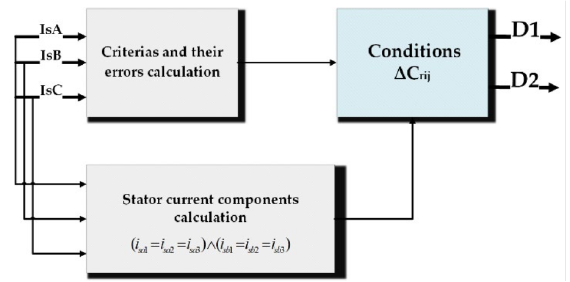
Figure 8. General diagram of current sensor fault detector algorithm.